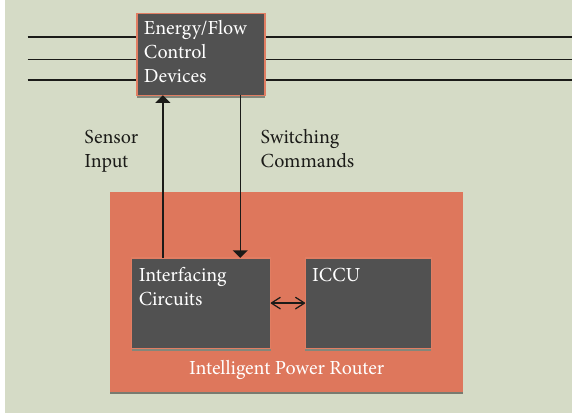
Figure 1: Basic elements of an